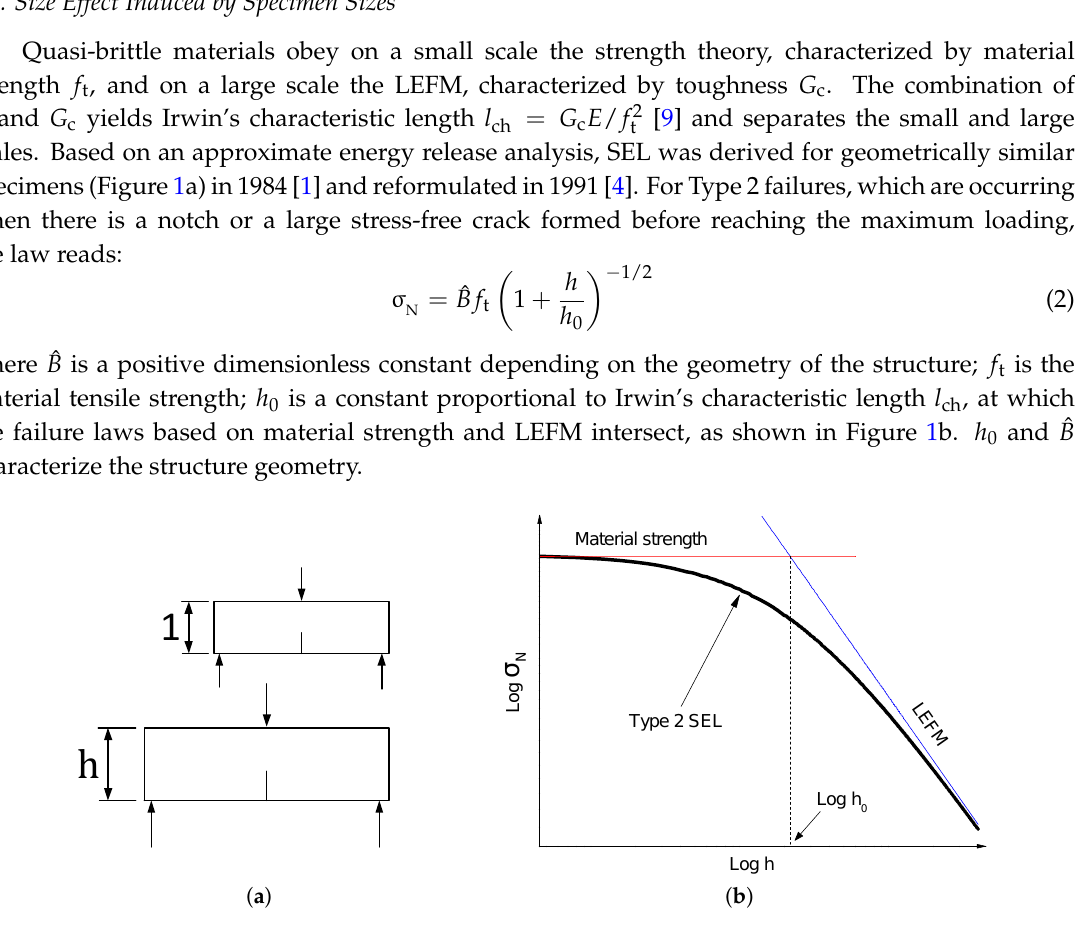
Figure 1. ( a ) Similar cracked structures and ( b ) Size Effect Law (SEL) bridging the failure mechanisms of material strength and Linear Elastic Fracture Mechanics